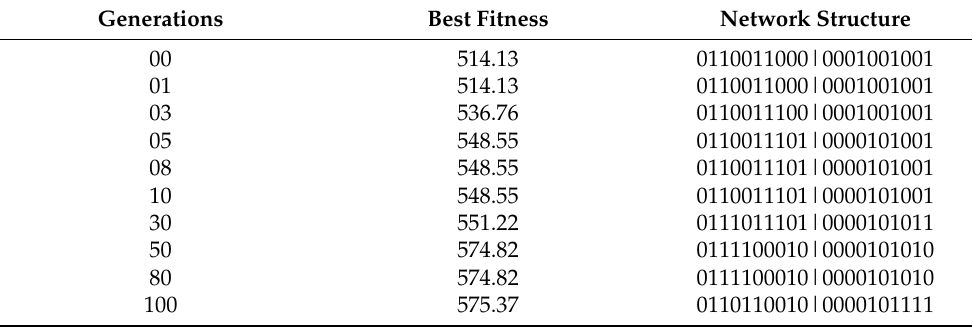
Table 7. The best fitness and corresponding network structure in Dataset 1.